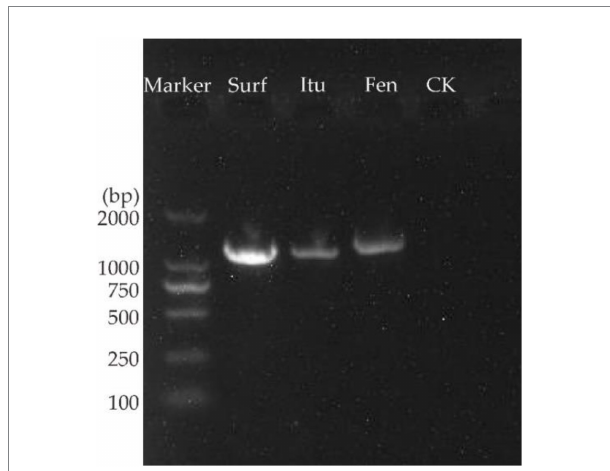
FIGURE 4 PCR amplification of antifungal LPs biosynthetic genes in B. subtilis